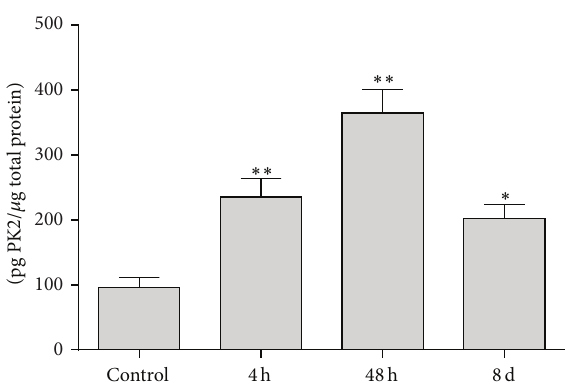
Figure 3: ELISA experiments showed that the PK2 protein expres- sion was increased in all bladders following CYP treatment. The PK2 protein levels increased significantly at each time point after CYP injection relative to those of the control bladders (no CYP). Sample size 𝑛 = 5–7 for each group. ∗∗ indicates 𝑃 < 0.01 ; ∗ indicates 𝑃 < 0.05 .